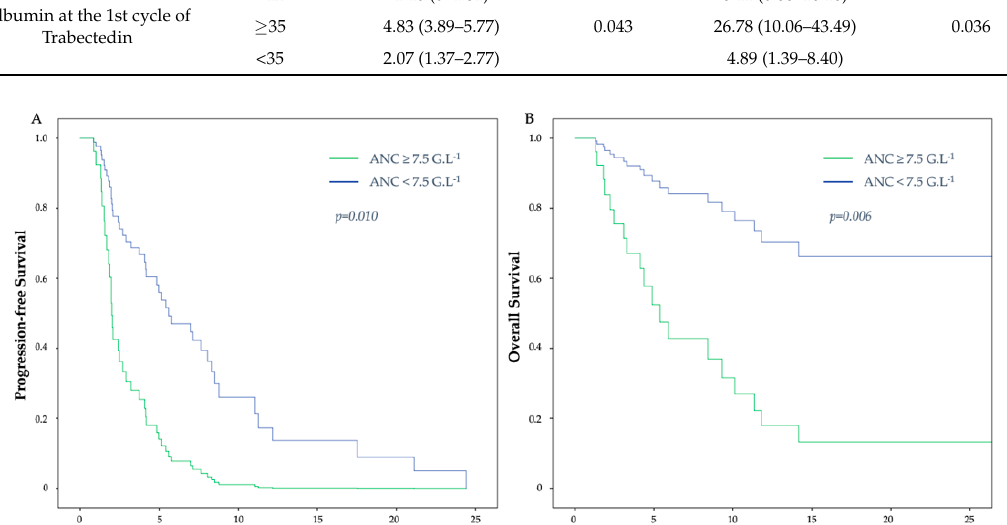
Figure 2. Cox-adjusted curves of progression-free survival ( A ) and overall survival ( B ) in patients with ANC < or ≥ 7.5 G/L. Table 2. Univariate analysis of factors associated with progression-free survival (PFS) and overall survival (OS).